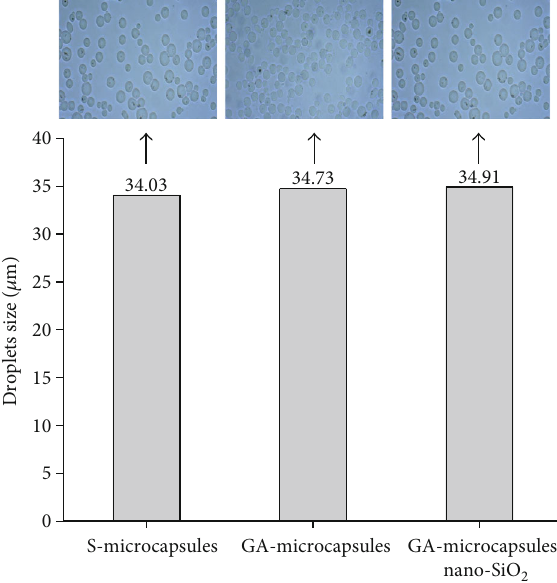
Figure 3: Droplet sizes of SMs, DMs, and DMs/nano-SiO corresponding droplet